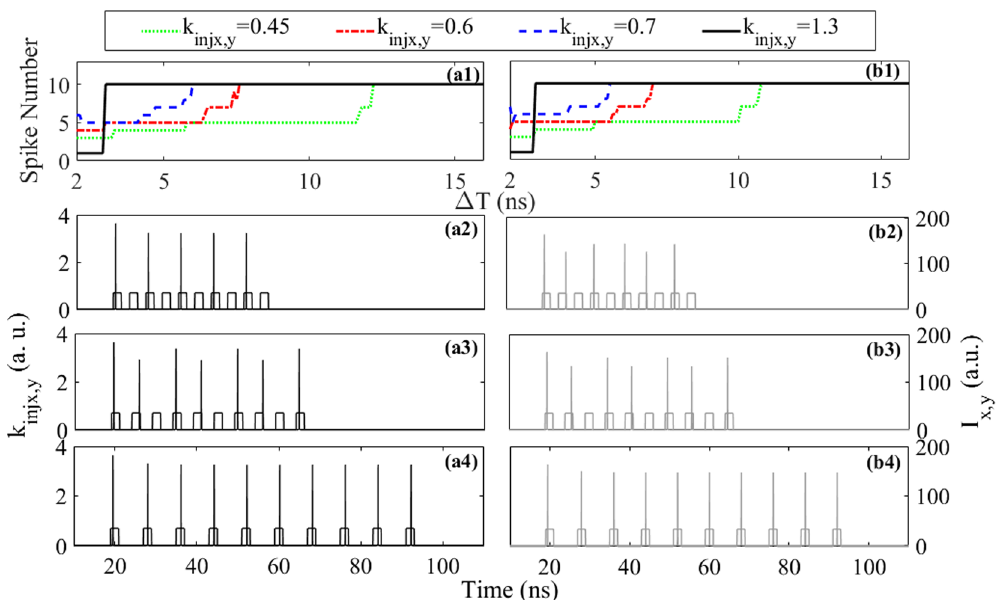
Figure 6. The spike number as functions of bit period Δ T ( a1 ) for XP mode and ( b1 ) YP mode. The time series of responses ( a2 )–( a4 ) in the XP mode and ( b2 )–( b4 ) YP mode, with Δ T = 4 ns in ( a2 ) and ( b2 ), Δ T = 5 ns in ( a3 ) and ( b3 ), and Δ T = 8 ns in ( a4 ) and ( b4